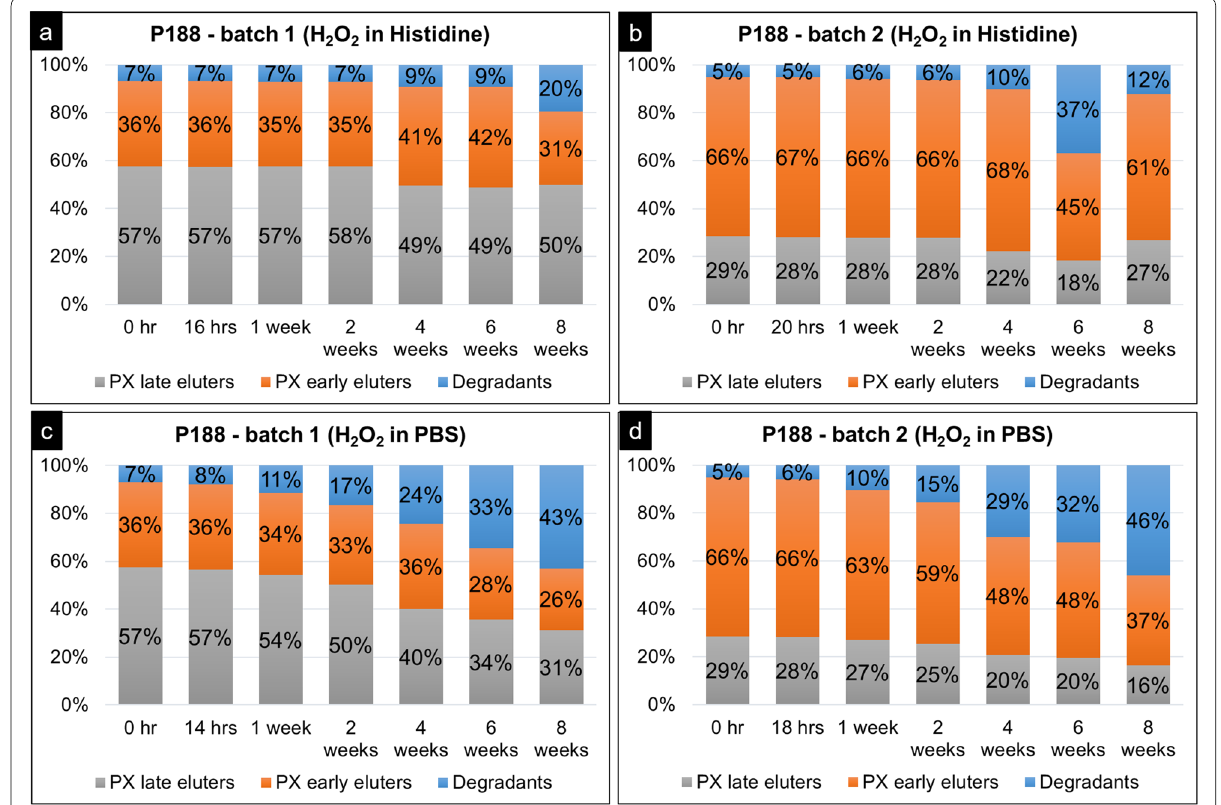
Fig. 2 The degradation of P188 by hydrogen peroxide (H 2 O 2 ) in histidine ( a , b ) and PBS buffers ( c , d